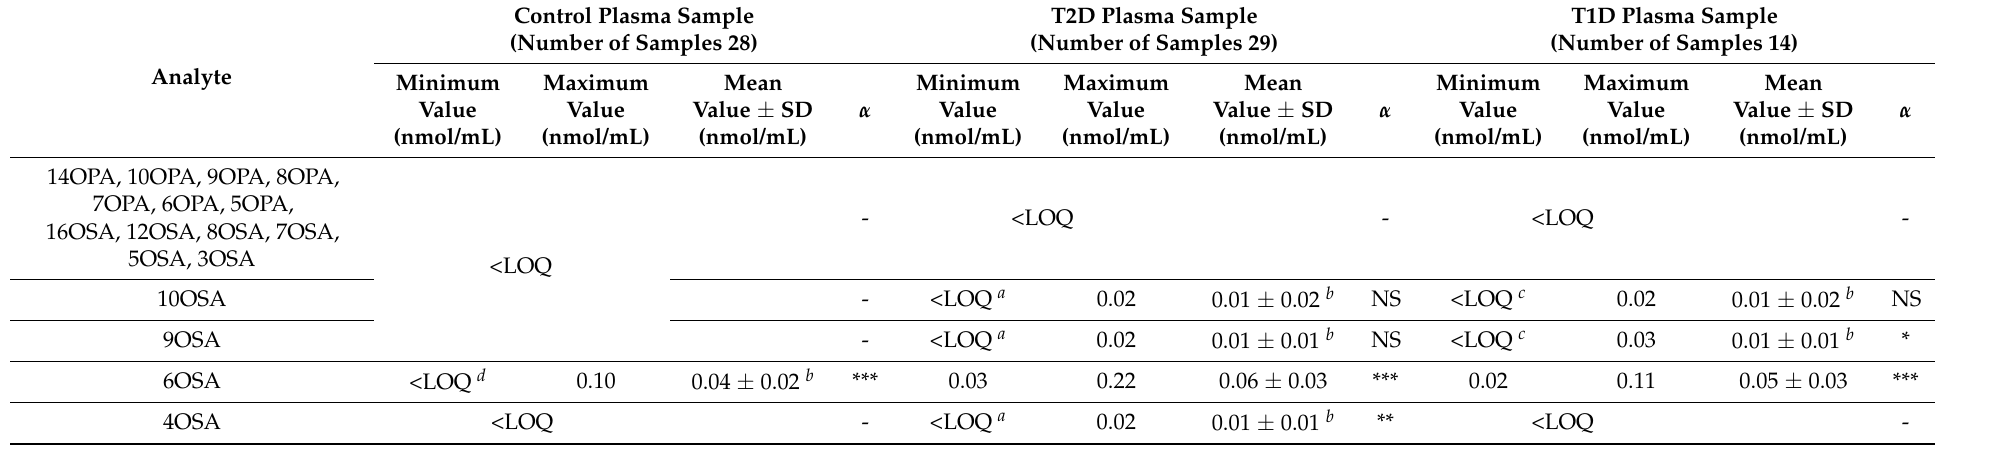
Table 2. Contents of free SOFAs in plasma samples (nmol/mL).